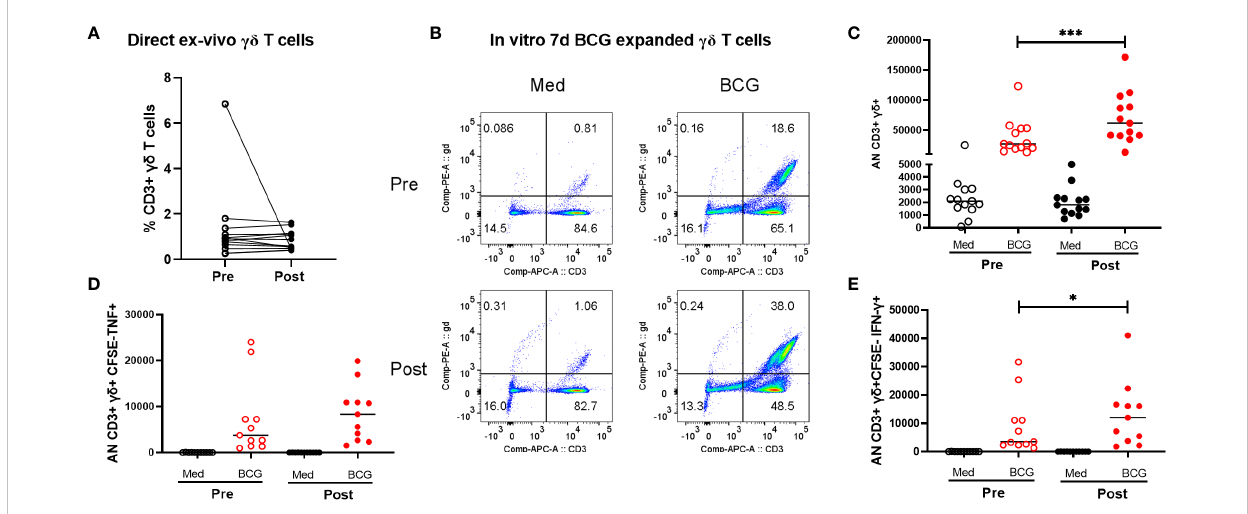
FIGURE 1 Comparison of peripheral gd T cells in volunteers pre- and post-BCG vaccination. Direct ex vivo fl ow cytometric results for 10 volunteers pre- and post- BCG vaccination are shown in panel (A) ( gd T cell frequencies of total CD3+ T cells). No signi fi cant differences were detected comparing these direct ex vivo samples collected pre- and post-BCG vaccination. However, after BCG stimulation and 7-day expansion periods in vitro as we have previously reported gd T cell immune responses were signi fi cantly increased after BCG vaccination For these in vitro expansion studies, CFSE labeled PBMCs were cultured with BCG (MOI =0.03) for 7 days. PMA (50 ng/mL), ionomycin (1µg/mL) and Gogistop (1,000×) were added to the cells before surface and intracellular staining. Panel (B) shows representative fl ow cytometric results for one - volunteer studied pre- and post – BCG vaccination. Panel (C) includes the composite data for all 10 volunteers. Absolute numbers, calculated as the percentages gd T cells times the total viable cells present on day 7, are shown. Presented in panels (D, E) are similar quanti fi cations for the absolute numbers of CFSE- gd TCR+ cytokine producing- T cells (TNF vs IFN-r producing cells, respectively) from